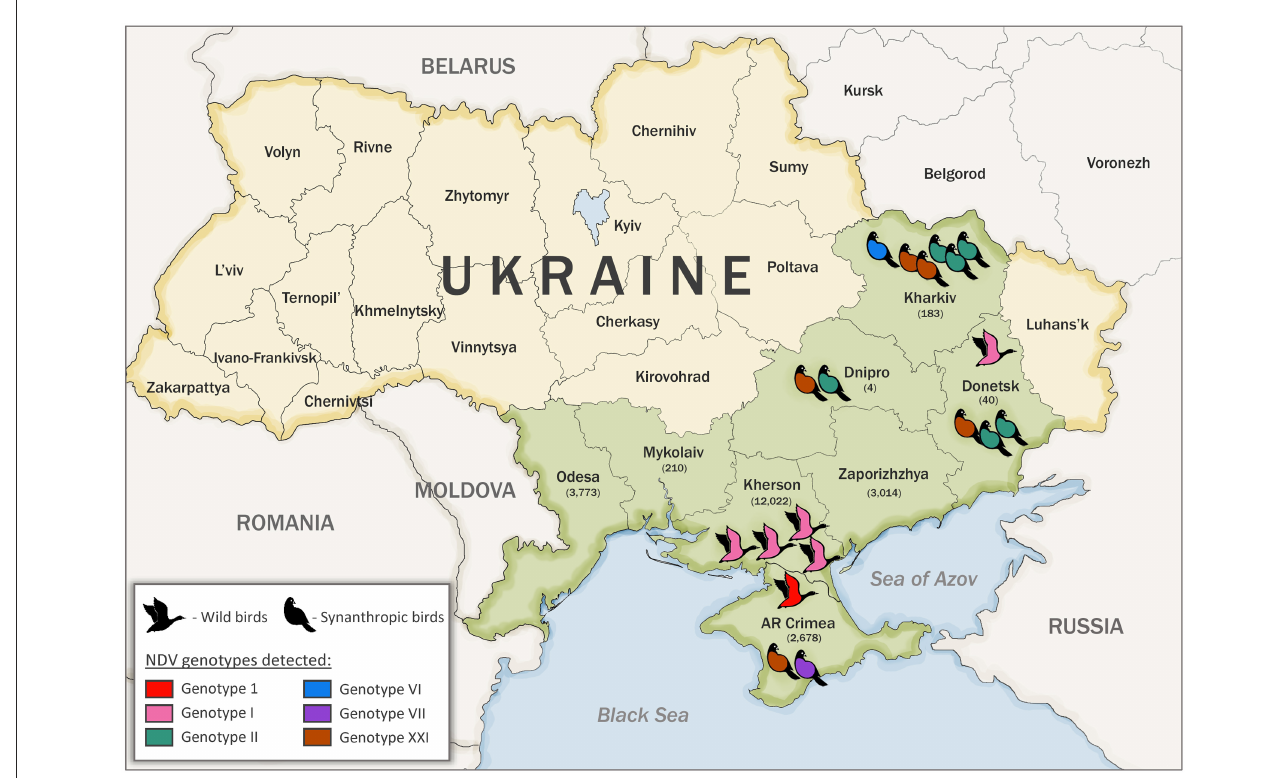
FIGURE1 Sample collection number, bird type, and location in Ukraine. Sampled regions are indicated in green color. The number of collected samples are indicated in parenthesis under the name of each region. Genotypes detected in this study are shown in red (genotype 1, class I), pink (genotype I, class II), teal (genotype II, class II), blue (genotype VI, class II), purple (genotype VII, class II), and brown (genotype XXI, class